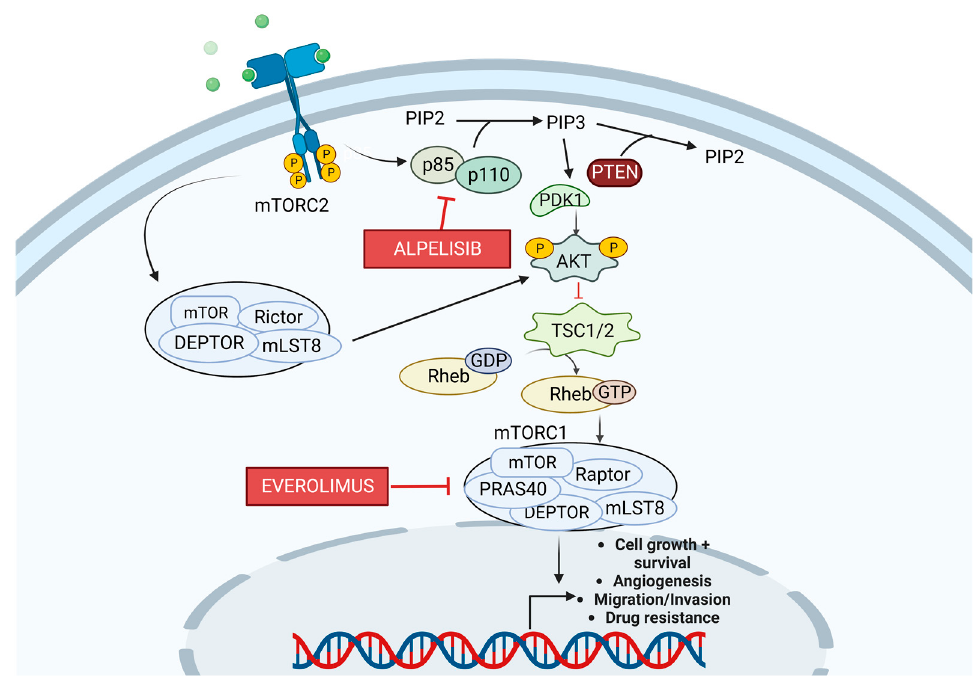
Figure 4. Diagram of the p85/p110 (PI3K) signaling pathway. PI3K leads to the formation of the second messenger, PIP3. PDK1 and AKT are then recruited to the membrane. PDK1 and mTORC2 phosphorylate AKT, fully activating it. AKT then phosphorylates TSC, which is a negative regulator of mTORC1. Alpelisib is a PI3K inhibitor, and Everolimus is an mTOR inhibitor. Created with Bio-